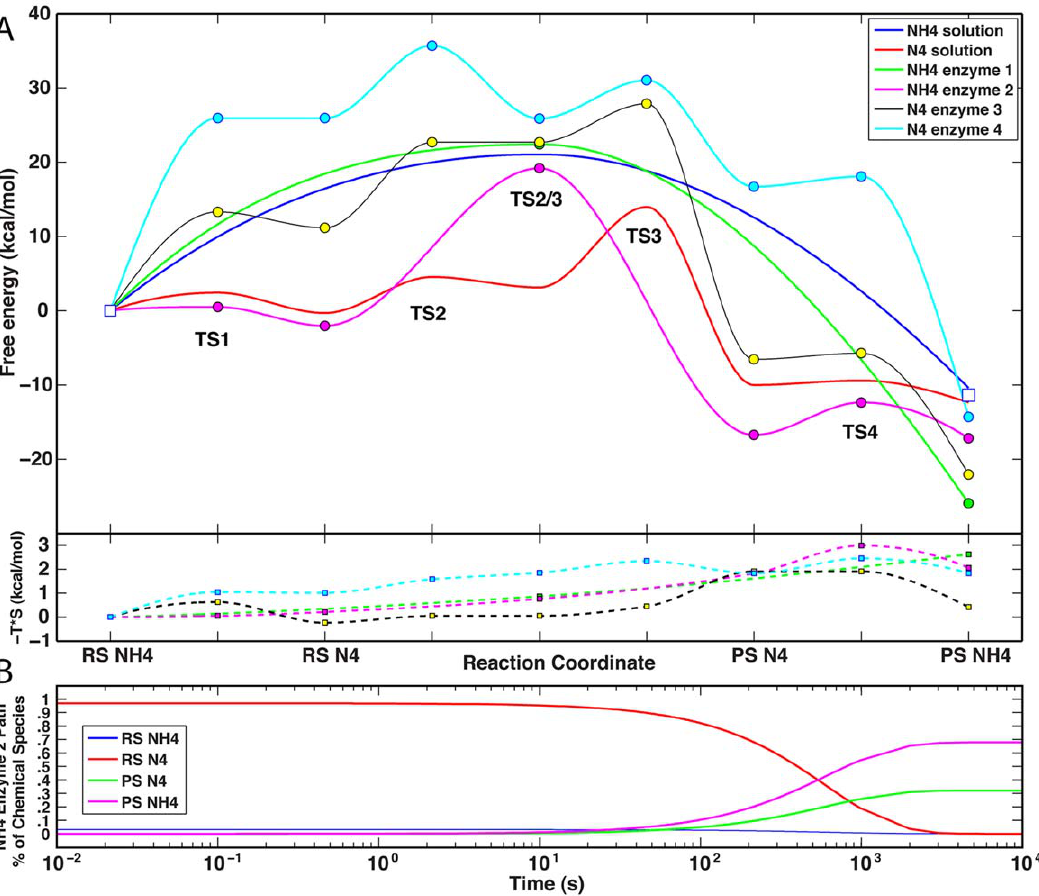
Figure 6. Free energy profiles of the cyclization reaction in the enzyme. A. The free energy profiles for the formation of the bicyclic compound in four configurations of the enzyme:hydrolyzed biapenem complex (continuous lines and colored circles) are superimposed on the profiles of the same reaction in water with protonated and unprotonated N4 (blue and red lines, respectively), as already shown in Fig. 4A . All the profiles have their origin coincident with that of protonated reactant in solution (clear square on the left side). The difference in the free energy of the protonated product (PS NH4) between the catalyzed (cyan, magenta, yellow, and green circles) and the uncatalyzed reactions (clear square on the right side) reflects the difference in the free energy of binding ( D G bind ) of the reactant versus the product. Changes in the entropic contribution ( 2 T*S) to the free energy curves are shown in the lower quadrant with dashed lines and square markers of the corresponding color. B. Time course of the reaction corresponding to the magenta trace in panel A (enzyme configuration No. 2 in Table 1 ), starting from 100% hydrolyzed biapenem with N4 ionized (RS N4 in panel A).